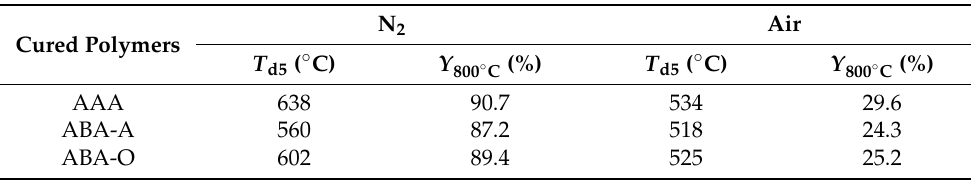
Table 7. The TGA analysis results of three polymers.